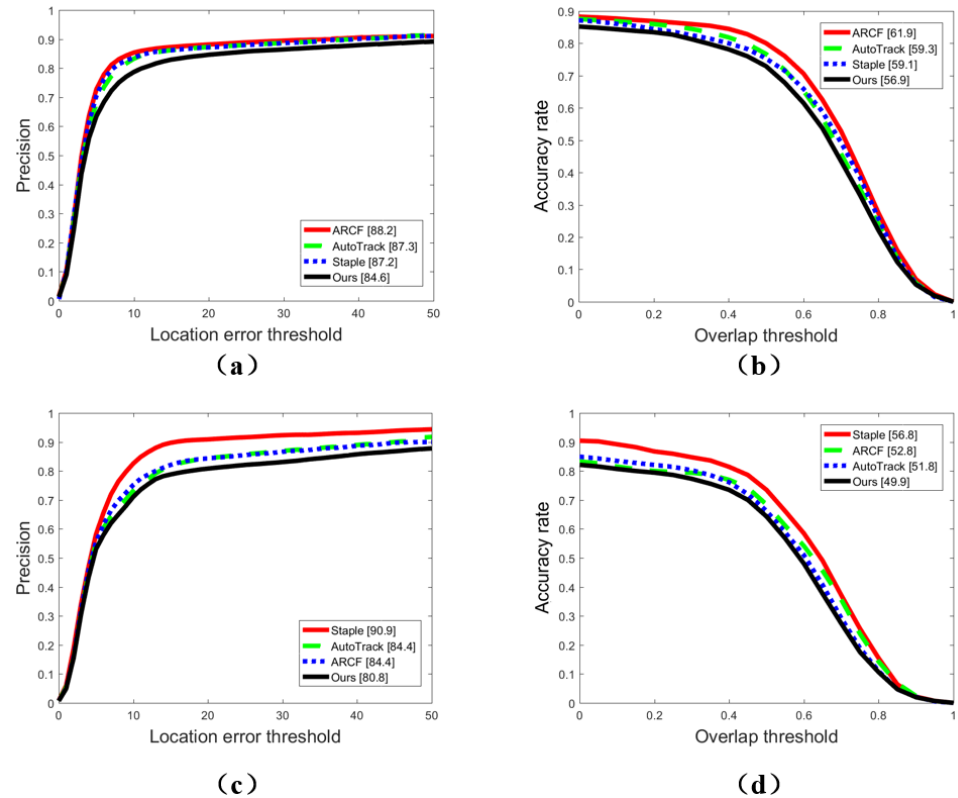
Figure 5. Comparison of the total precision and accuracy of different correlation filtering algorithms under different metrics. ( a ) is the total precision of different correlation filtering algorithms under TRE, ( b ) is the total accuracy of different correlation filtering algorithms under TRE, ( c ) is the total precision of different correlation filtering algorithms under SRE and ( d ) is the total accuracy of different correlation filtering algorithms under SRE.